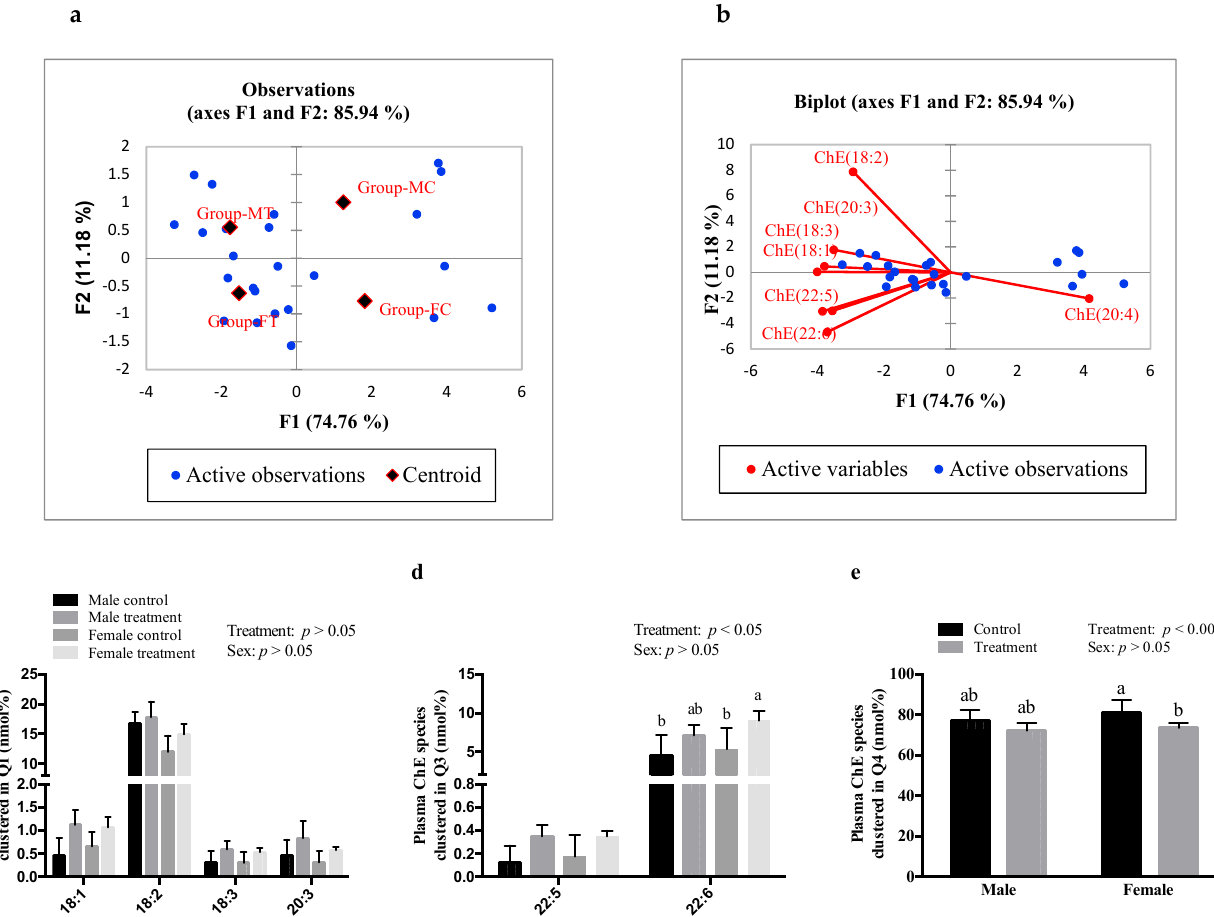
Figure 2. Intraperitoneal administration of SCFAs had a significant effect on plasma ChE fatty acyl composition. Principal component analysis showing ( a ) observation plot and ( b ) biplot of TG molecular species clustered in: ( c ) Q1—quadrant 1, ( d ) Q2—quadrant 2, and ( e ) Q4—quadrant 4. Data were analyzed using multivariant analysis, and two-way ANOVA followed by Tukey’s post hoc test. All data are expressed in mean ± SD. Different superscripts indicate significant difference amongst groups; p < 0.05 was considered significant ( n = 6). ChE—cholesteryl esters, FC—female control, FT—female treatment, MC—male control, MT—male treatment.